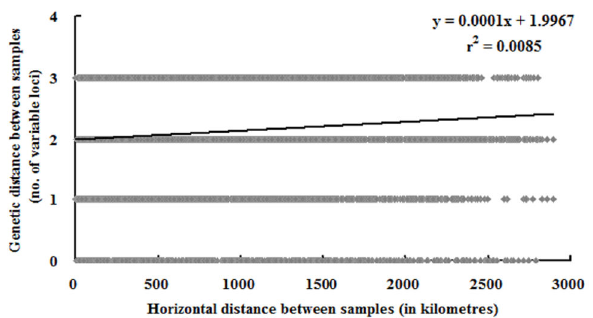
Figure 6. Mantel test between genetics and horizontal distance. Horizontal geographical distances means distances based on longitudinal–latitudinal coordinates. doi: